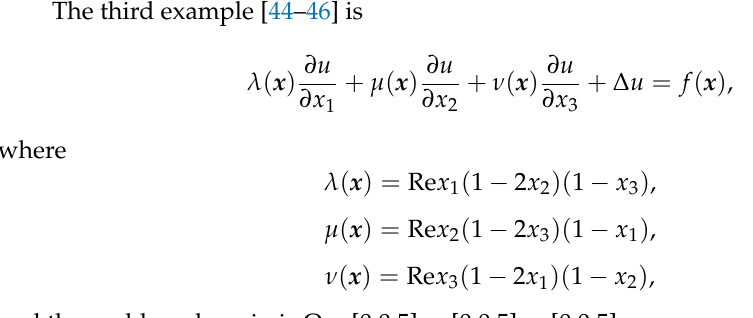
Figure 11. The comparison of numerical and exact solutions along x 2 -axis.